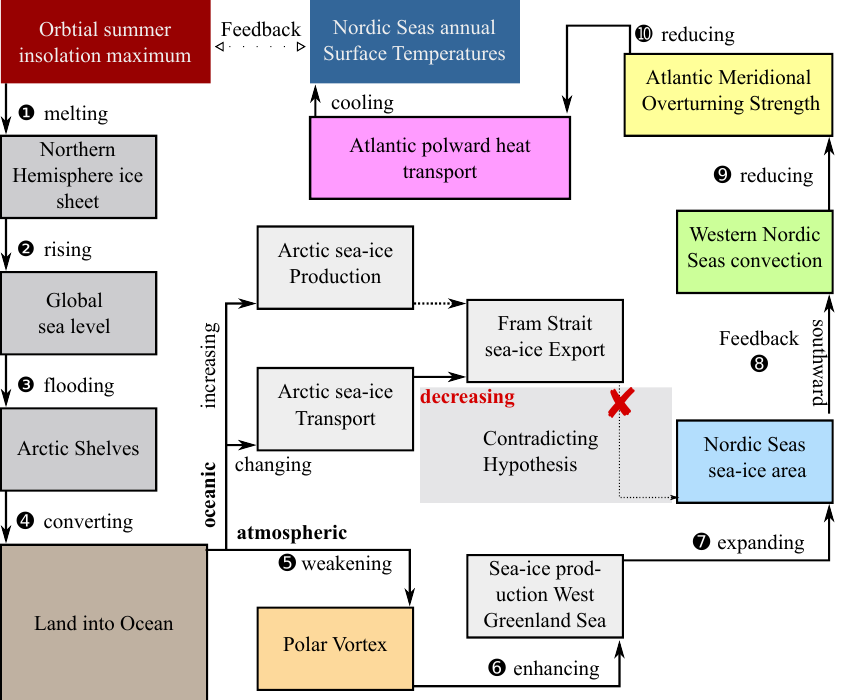
Fig. 9. Schematic 10 step way showing the connections between found feedbacks due to Arctic shelf flooding. In red is indicated where our results do not match our original hypothesis (we proposed increased Fram Strait sea-ice export and therefore an increase of Nordic Seas sea-ice area).